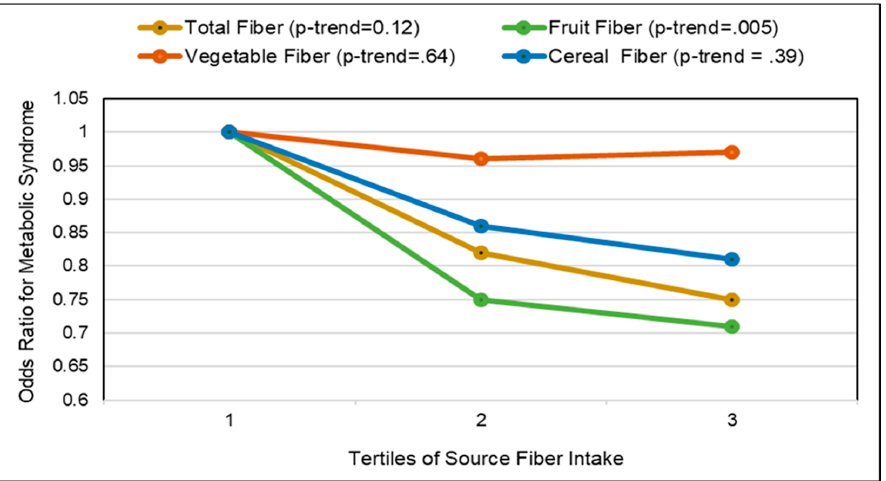
Figure 17. Odds ratio for Metabolic Syndrome by categories of fiber sources of intake (median) at baseline examination from the Tehran Lipid and Glucose Study (multivariate adjusted; total fiber (g) = 10.2, 14.1, and 21.6; fruit fiber (g) = 1.2, 2.7 and 5.2; vegetable fiber (g) = 1.2, 2.6 and 5.9; and cereal fiber (g) = 1.6, 3.2 and 4.5) [252].